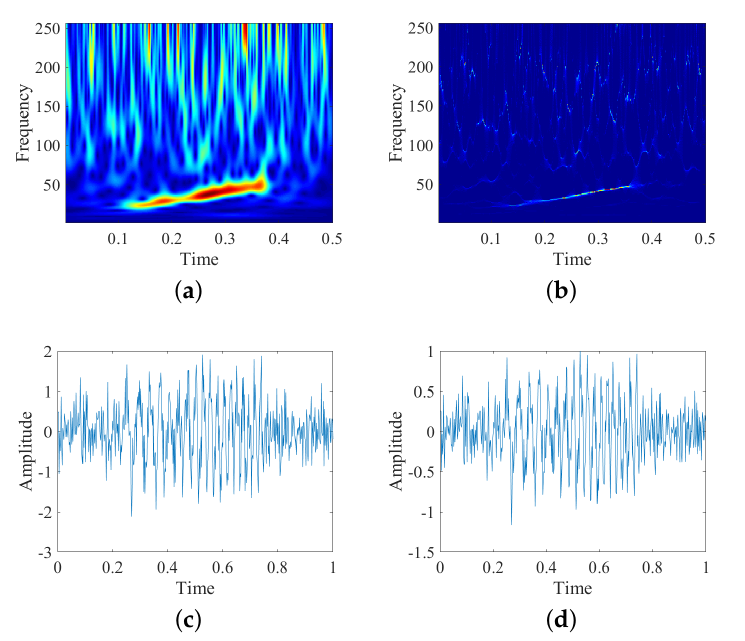
Figure 6. STFT and SST of the simulation signal sig ( t ) and the comparison of original signal and reconstructed signal. ( a ) STFT, ( b ) SST, ( c ) original signal, ( d ) reconstructed signal.